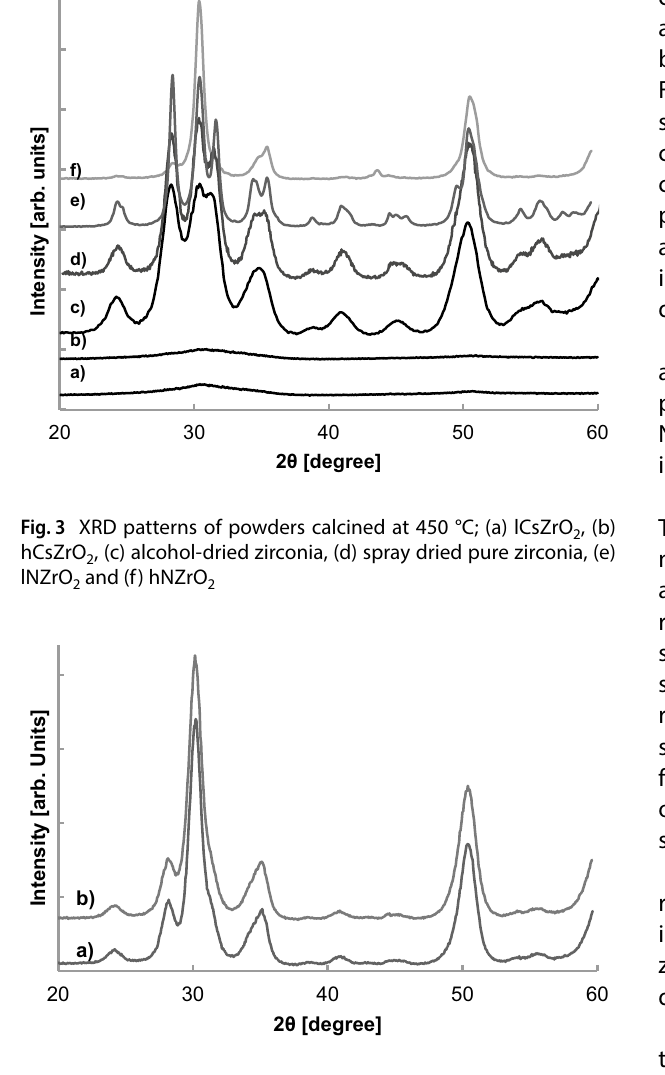
Fig. 4 XRD patterns of zirconia spray-dried with CsCl calcined at 550 °C; (a) l CsZrO and (b) hCsZrO 2 2